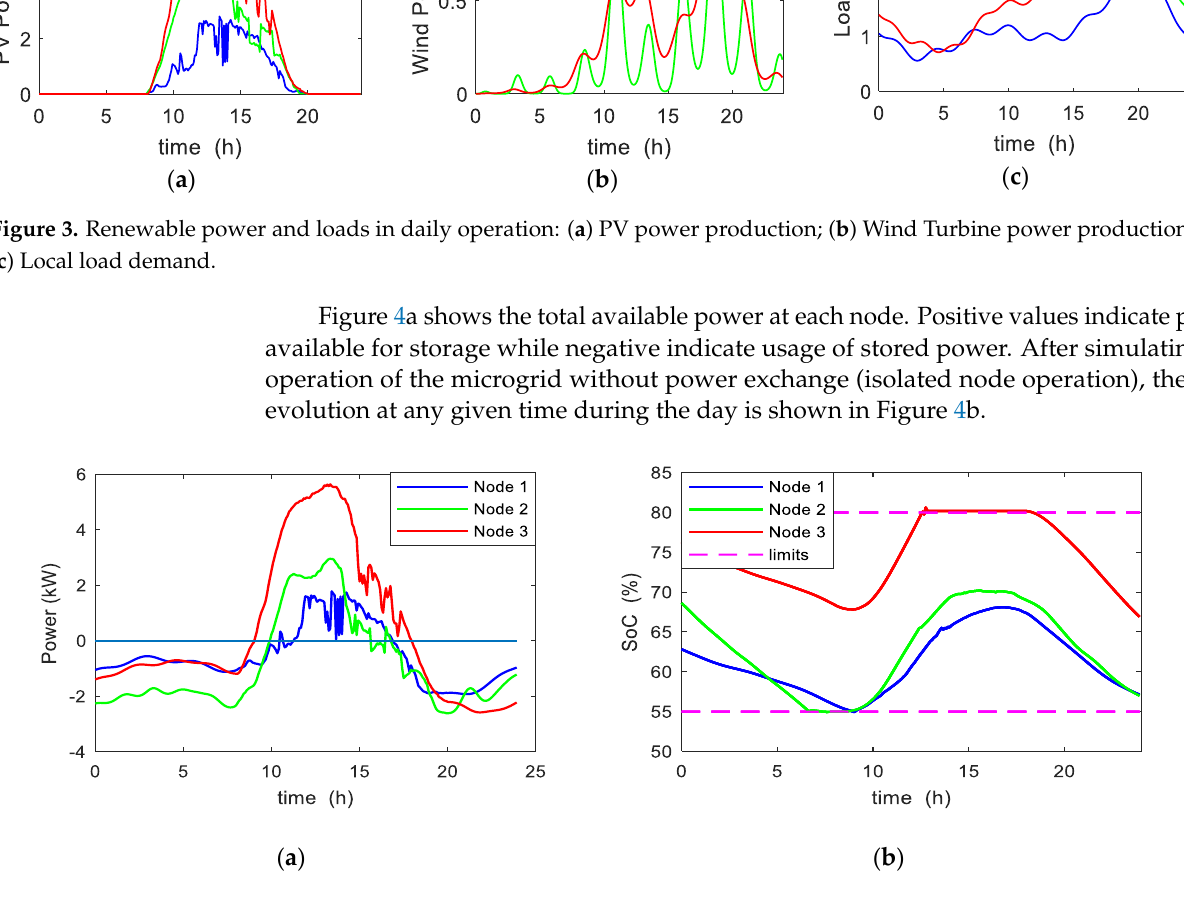
Figure 4. ( a ) Available power in the nodes; ( b ) Battery SOC in daily